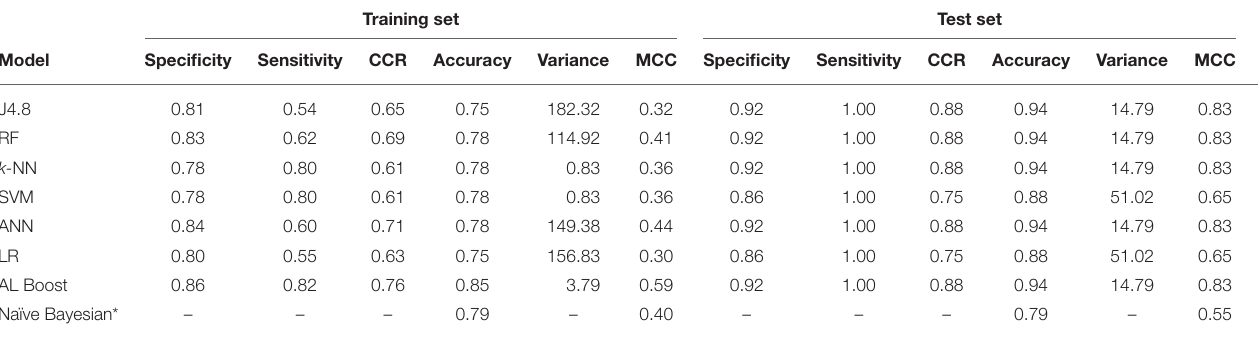
TABLE 6 | Classification results of anti-neoplastic vs. cardiovascular drugs, where specificity represents the cardiovascular drugs and sensitivity represents the anti-neoplastic. Training